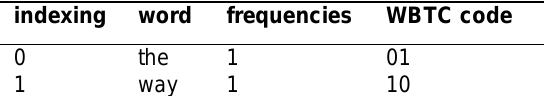
Table 15: Wt for Table 9